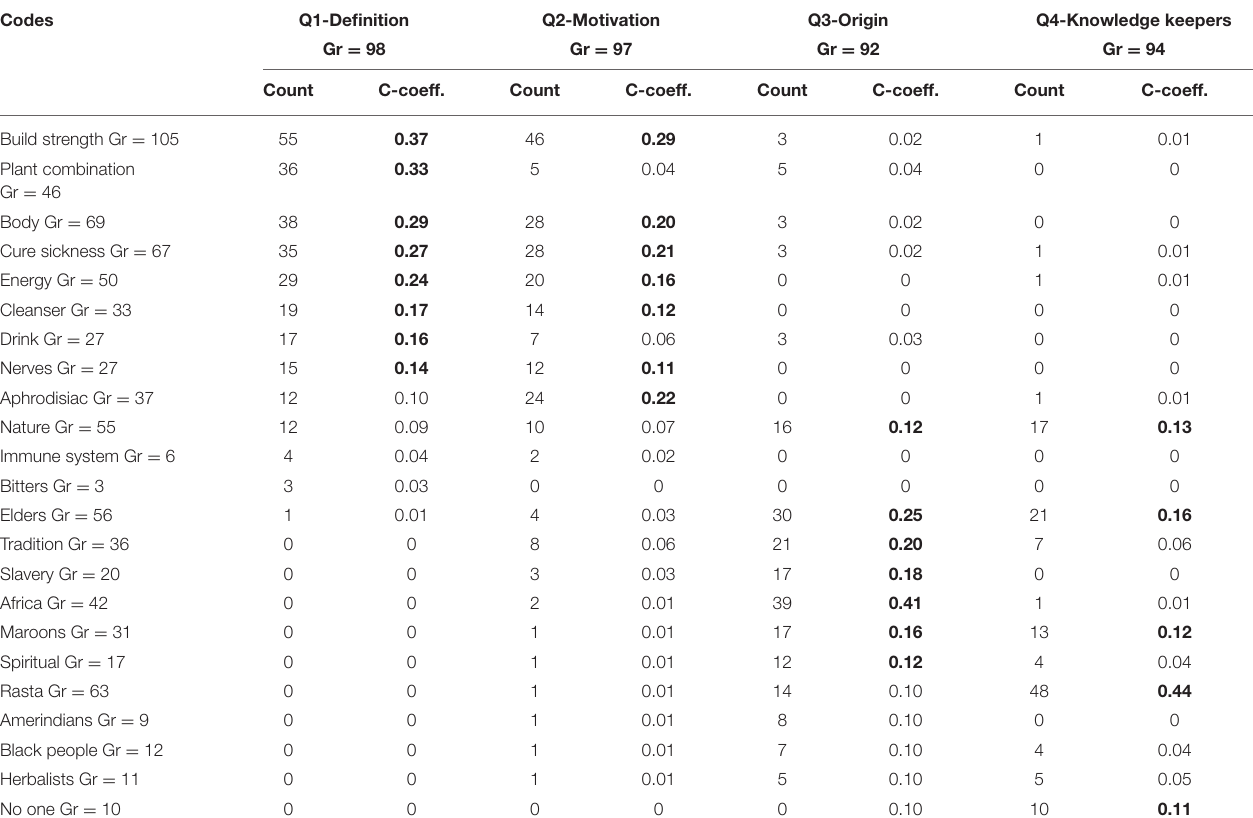
TABLE 2 | Quotation counts and strength of association (measured as the C-coefficient) between each code and four interview questions (Q1-Definition: What are Jamaican root tonics? Q2-Motivation: Why do Jamaicans drink root tonics? Q3-Origin: Where does this tradition come from? Q4-Knowledge keepers: Who is especially knowledgeable about root